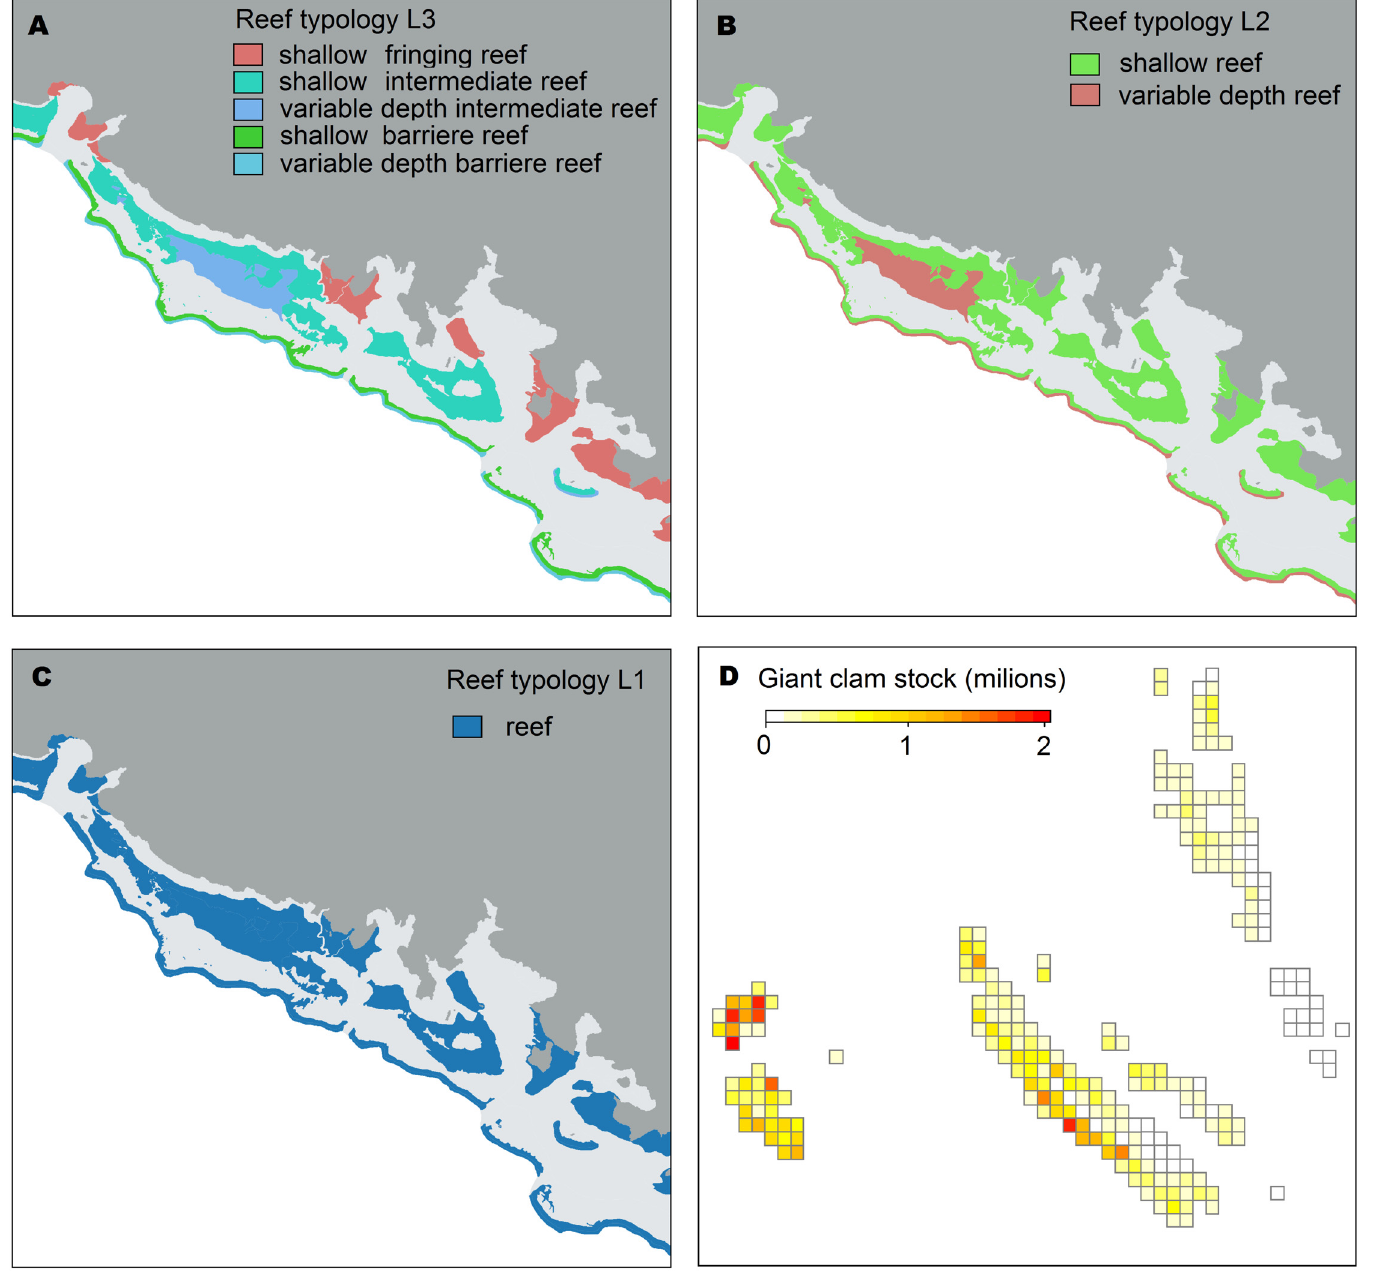
Fig 3. Illustration of how habitat composition and configuration were taken into account in this study. (A), (B), and (C) are habitat maps for south BOU (see Fig 2) established accordingto reef typologylevels L3, L2, and L1, respectively(see Table 3). (D) Estimated abundance of T . maxima for each habitat patch. Abundance is the product of habitat surface and density per habitat (the figure displayedhere was established on the basis of the L3 level, Table 3). Note that lower abundances were predicted in the south east part of New Caledonia and